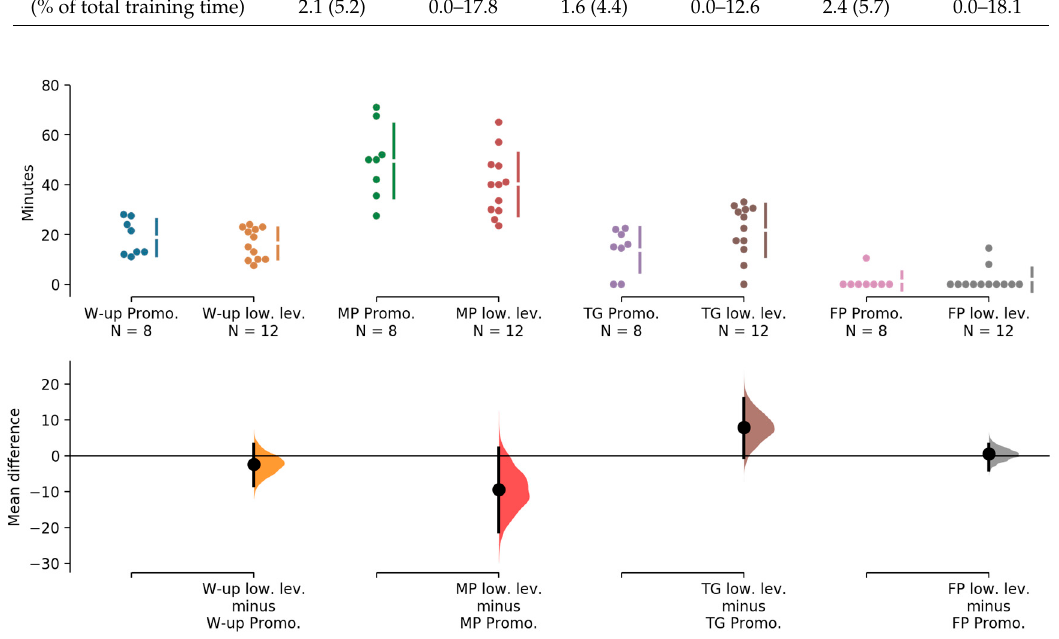
Figure 2. Comparison of training parts between the two performance levels (promotion vs. lower level). (W-up = warm-up; MP = main part; TG = training game; FP = finishing part; Promo. = promotion; low. Lev. = lower level).